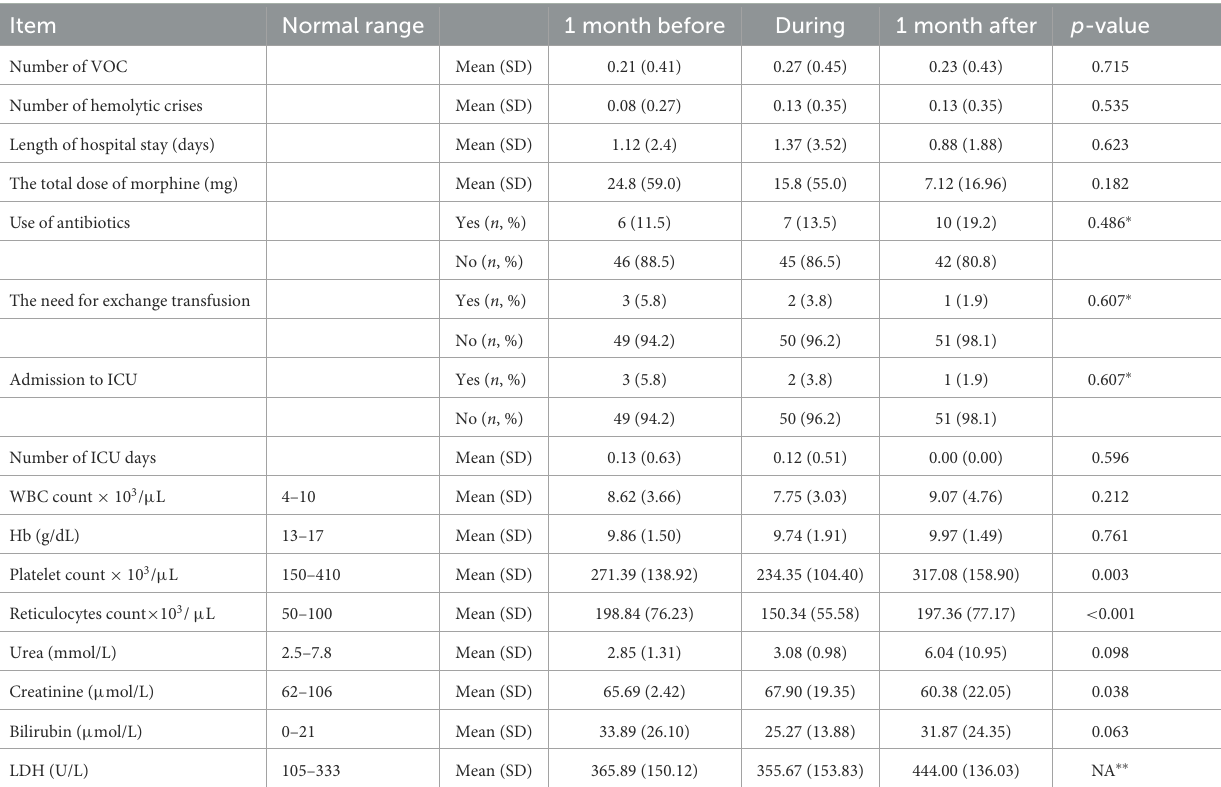
TABLE 2 Clinical and laboratory parameters among SCD patients 1 month before, during, and 1 month after Ramadan.